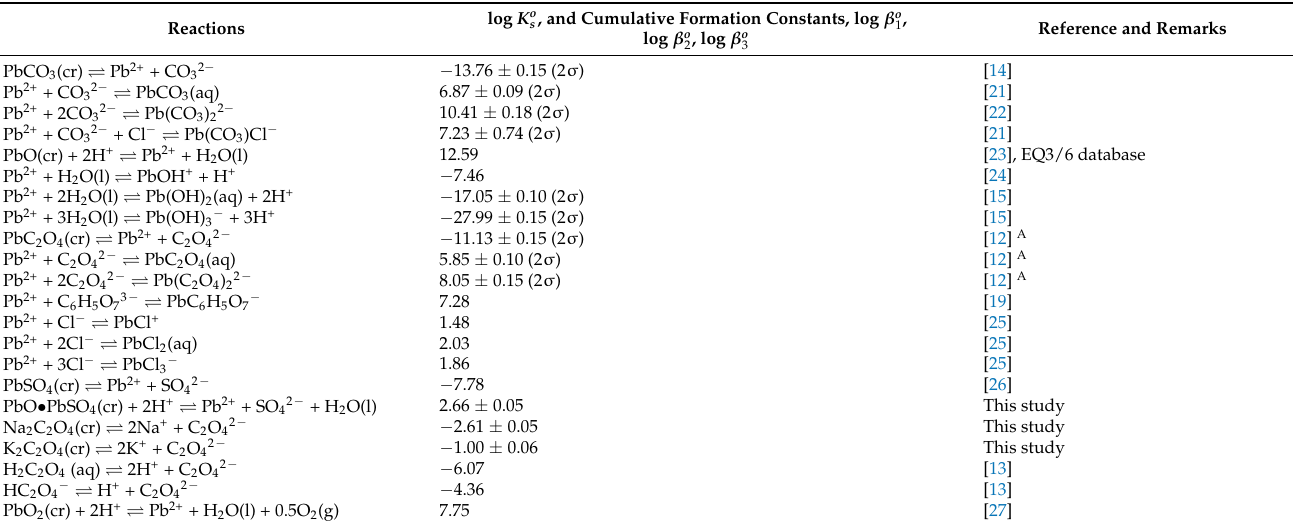
Table 1. Equilibrium constants at infinite dilution at 25 ◦ C and 1 bar for key chemical species relevant to recycling of lead pastes from lead–acid batteries.